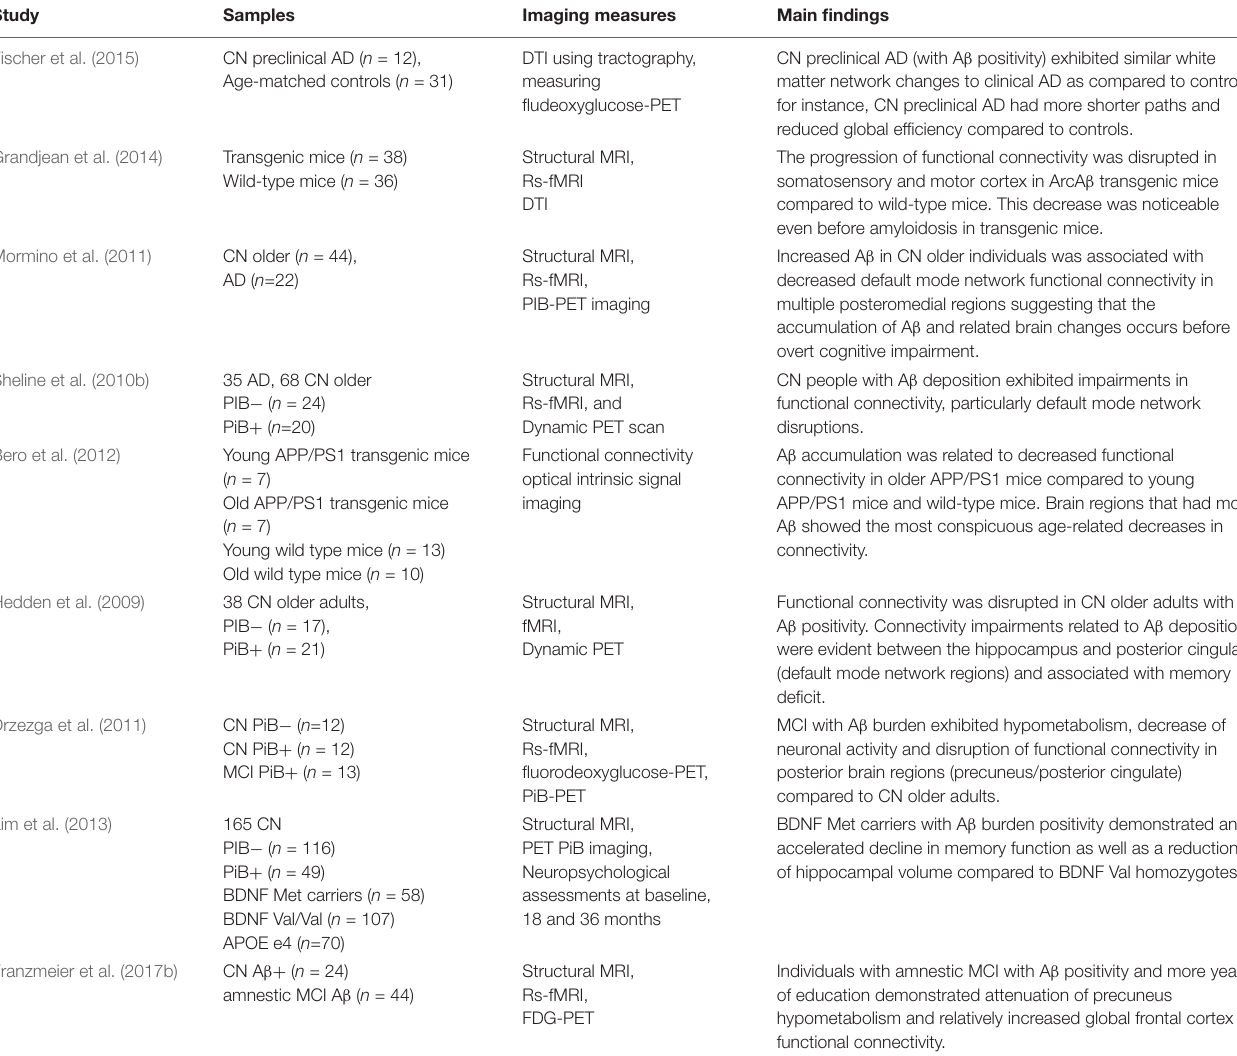
TABLE 1 | Studies examining functional connectivity and amyloid-beta in healthy aging and Alzheimer’s